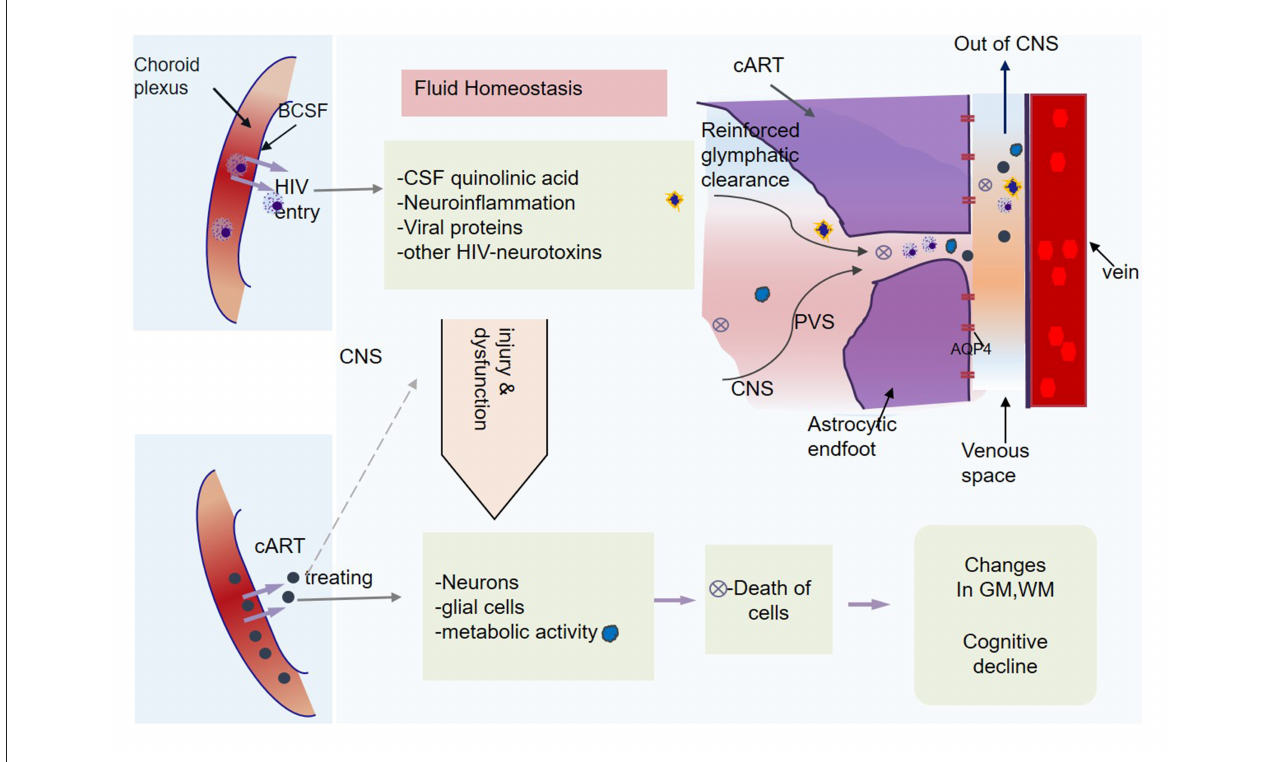
FIGURE 6 | Central nervous system (CNS) homeostasis and glymphatic clearance. HIV elevates the cerebrospinal fluid (CSF) quinolinic acid levels. It also induces neuroinflammation, viral proteins that cause injury to neuronal and glial cells, including astrocytes, leading to the death of some cells. The metabolic activity and functions of CNS cells become subject to ongoing HIV injuries. In response to the toxic homeostasis and infectious chemicals, the brain might recruit higher-order mechanisms (AQP4 polarization processes, pulsatility, and cerebral vascular compliance) for homeostasis